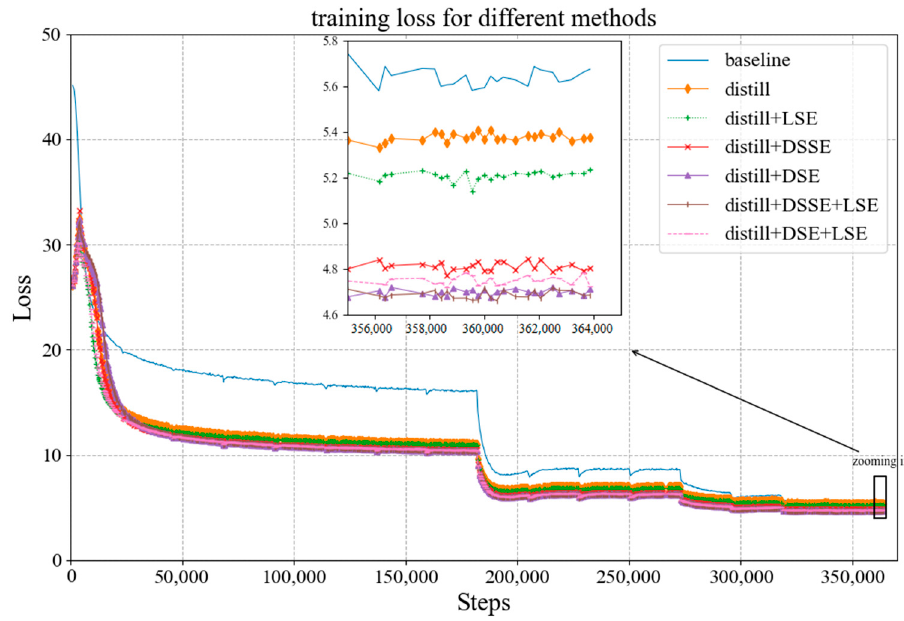
Figure 11. Training loss curves of the models with different modules in the proposed training pattern.